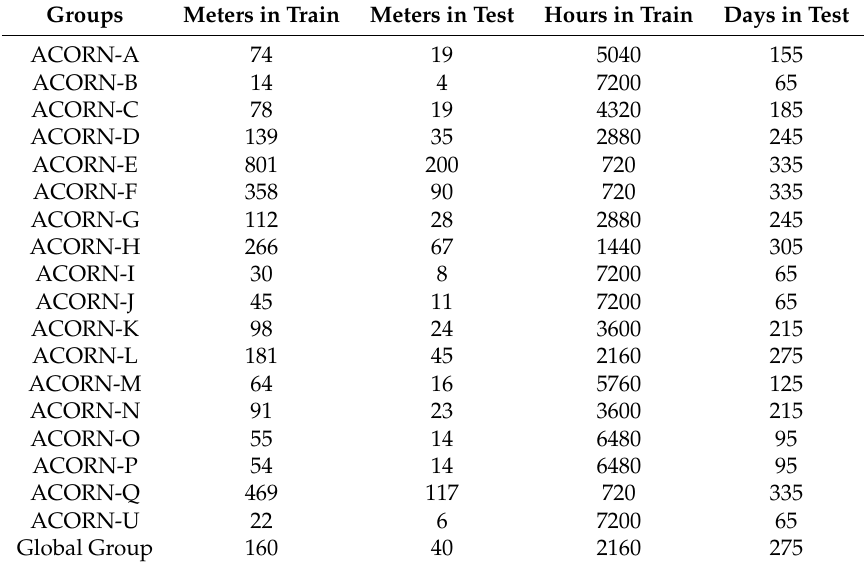
Table 1. Summary of the complete